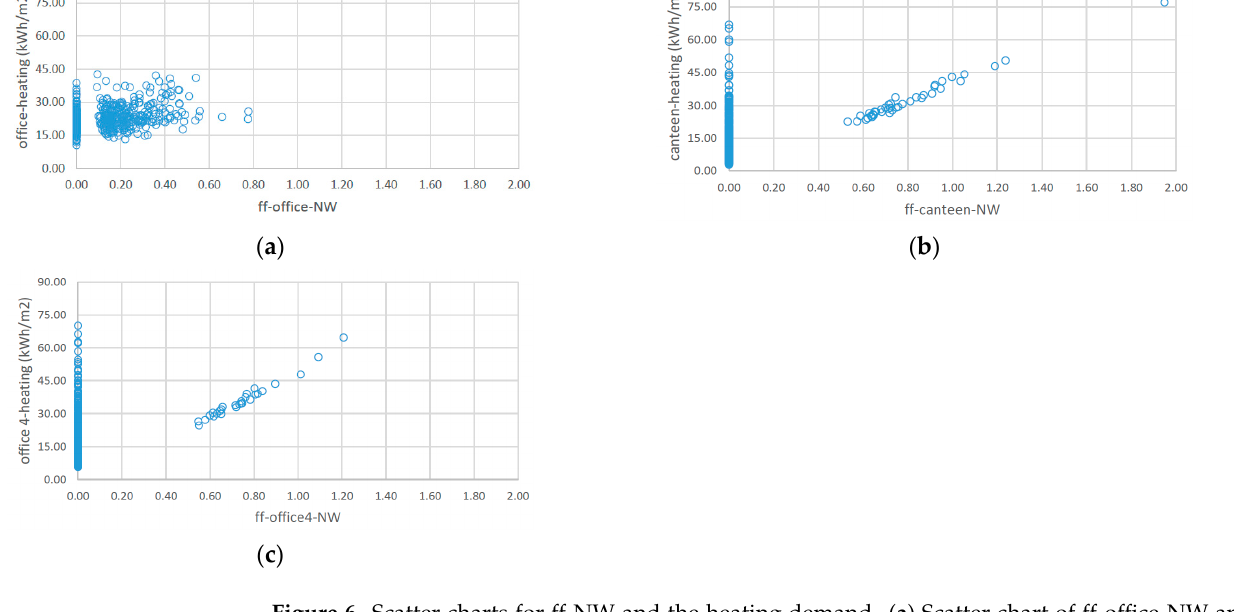
Figure 6. Scatter charts for ff ‐ NW and the heating demand. ( a ) Scatter chart of ff ‐ office ‐ NW and heating demand of offices; ( b ) Scatter chart of ff ‐ canteen ‐ NW and heating demand of canteen; ( c ) Scatter chart of ff ‐ office4 ‐ NW and heating demand of office ‐ 4. Note: The zero ff ‐ ratio in these figures means that in the layout, no room was located facing that specific orientation. For instance, if ff ‐ office ‐ NW is zero, this means that in the layout, no office was oriented NW. Table 8. Correlation coefficients between energy demands of offices and ff ‐ office ‐ orientations (ff ‐ O ‐ orientations).